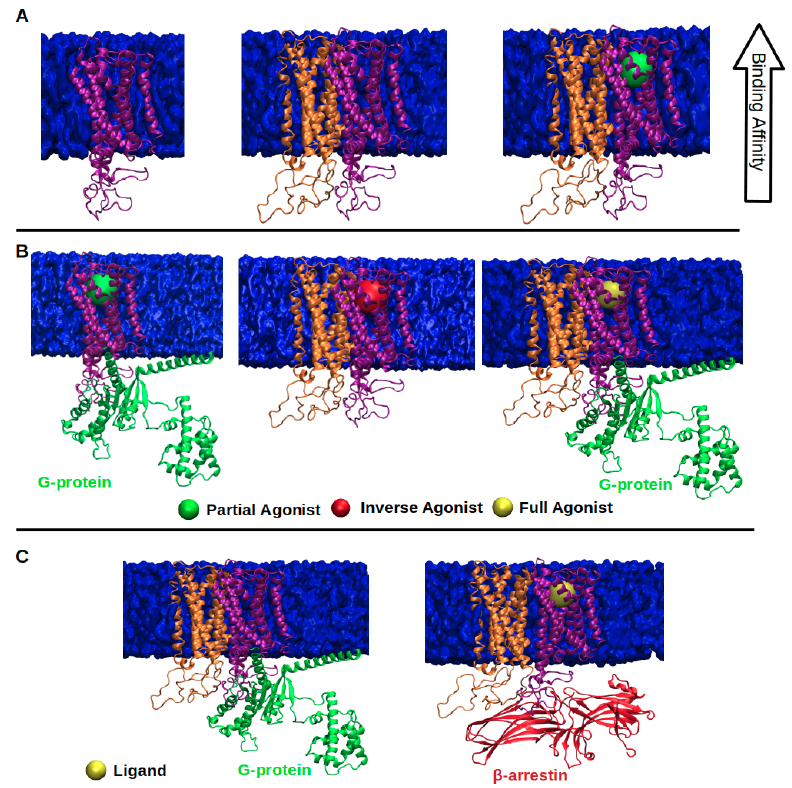
Figure 5. ( A ) depicts that ligand binding affinity of monomer (purple) increases in the presence of its partner protomer (orange); ( B ) ligand efficacy of monomer (purple) decreases (middle) or increases (right) in the presence of its partner (orange) when they form dimer; ( C ) functional selectivity of dimer changes in the presence of protomer; concurrently, G protein is substituted with β